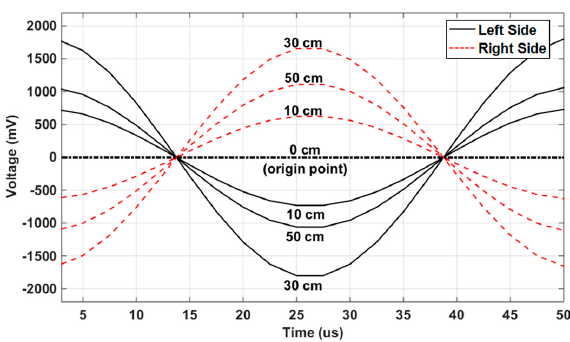
Figure 12. Simulated sensor coil voltage output vs. time, showing the left side and right side positions can be clearly identified.